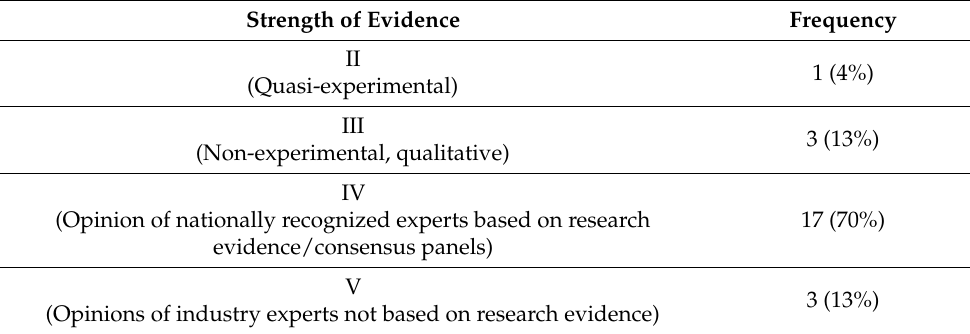
Table 2. Summary of quality